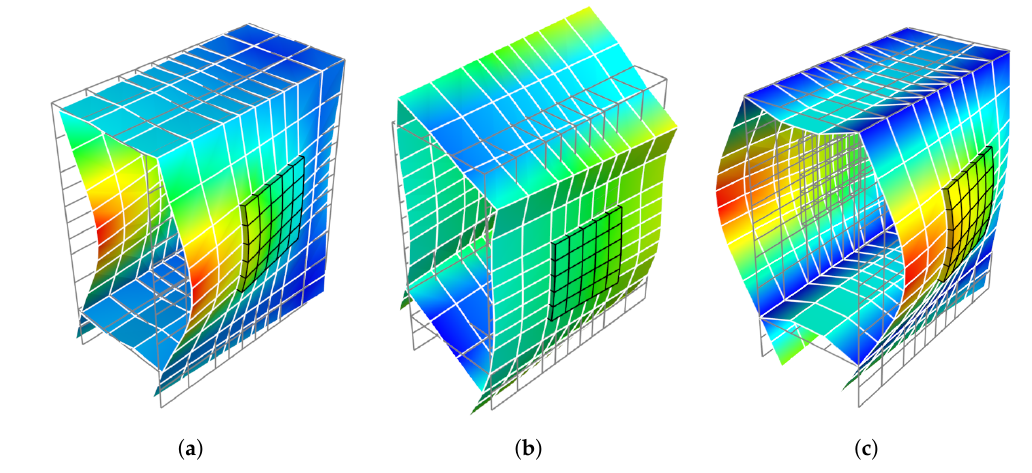
Figure 13. Wave shapes of the at 1000Hz: ( a ) wave 0; ( b ) wave 4; ( c ) wave 5.